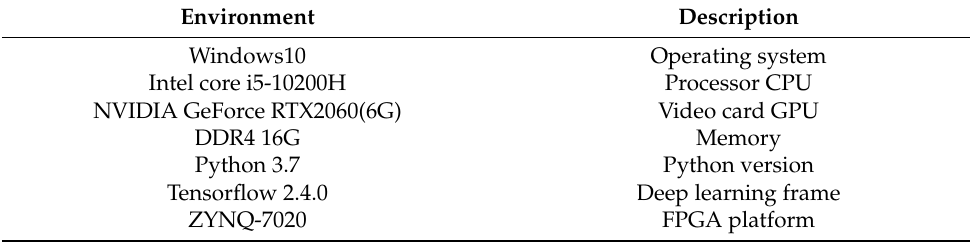
Table 1. Environmental